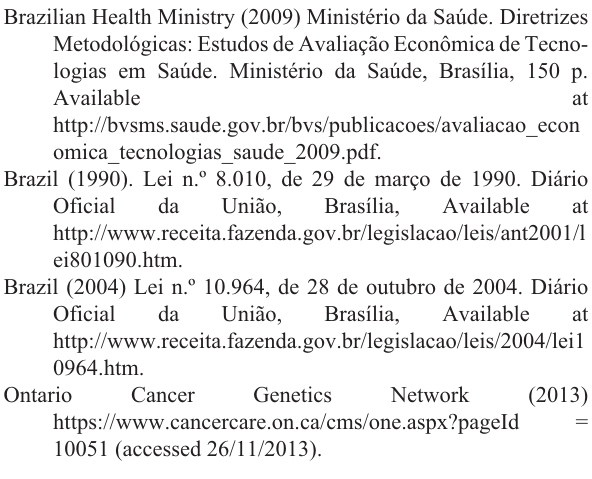
Table S1 - DNA isolation from peripheral blood (Commer- cial column extraction kit - GE) for 12 samples. Table S2 - DNA isolation from peripheral blood (Commer- cial kit - GENTRA Puregene) for 16 samples. Table S3 - DNA isolation from formalin fixed paraffin em- bedded tissue (Commercial kit PROMEGA) for 24 sam- ples. Table S4 - DNA quantification using the Nanodrop equip- ment for 100 samples. Table S5 - MLPA (12 samples and 4 controls). Table S6 - PCR product purification for 96 samples. Table S7 - Sanger sequencing 96 samples - unlabelled. Table S8 - Microsatellite instability (MSI) - (94 samples + 2 controls). Table S9 - Immunohistochemistry panel - 4 antibodies against MMR proteins, per patient. Table S10 - Preparation of formalin fixed paraffin embed- ded (FFPE) tissue for scraping before DNA extraction. Table S11 - Summary available